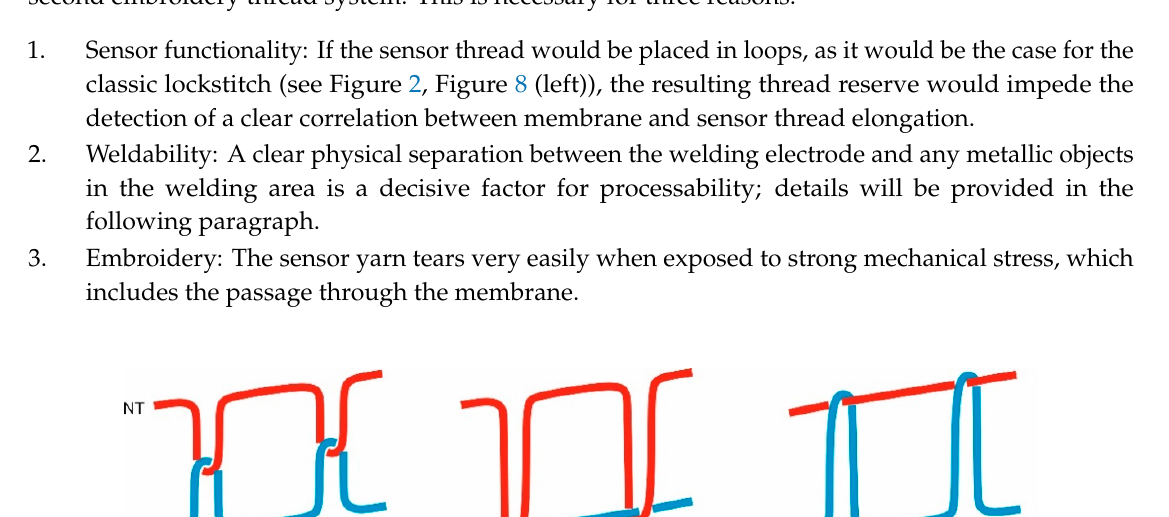
( b ) Figure 9. Graphical illustration of ( a ) HF welding with a conductive sewing thread and ( b ) a finished HF welded seam with integrated sensor. 3.3. Finite Element Analysis of the Strain Conditions at Membrane Welds and Textile Integrated Strain Measurement 3.3.1. Validation of the FEA Models The numerical model of the membrane was tested to assure the correct mechanical responding of the assigned nonlinear orthotropic material model. A model of the tensile test, according to Figure 3, was carried out and the membrane material model was virtually tested under realistic testing conditions (see Section 2.2.4.). A comparison between experimental and numerical results is illustrated in Figure 10; the curves are in excellent agreement.